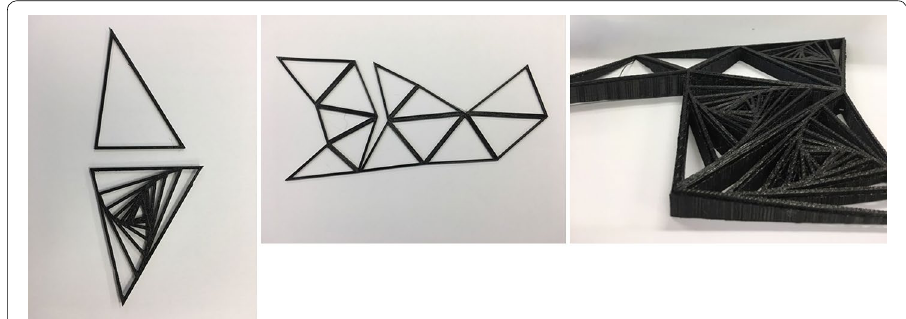
Fig. 12 a Basic units of middle size (left), b pattern printed in connected mode (center), c printing with supports (right)